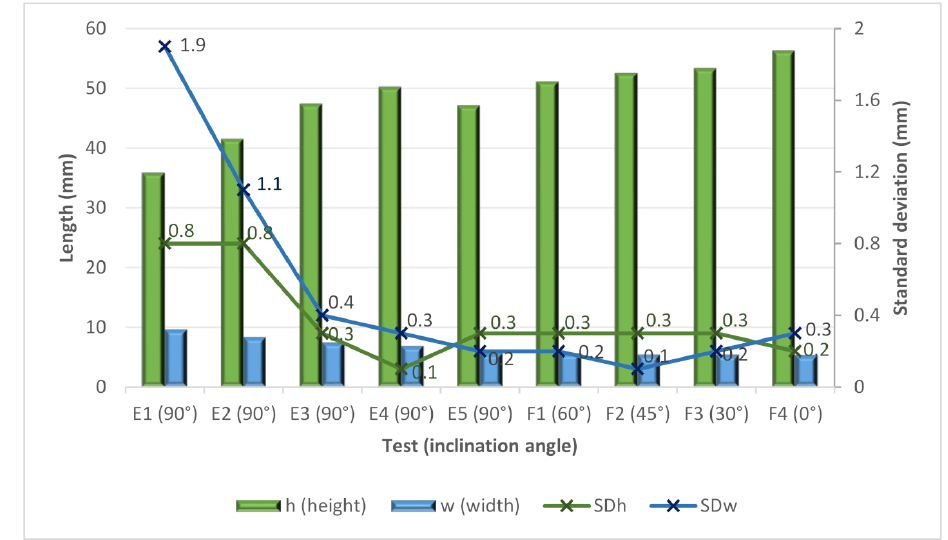
Figure 13. Height, width and standard deviations for the E and F samples.